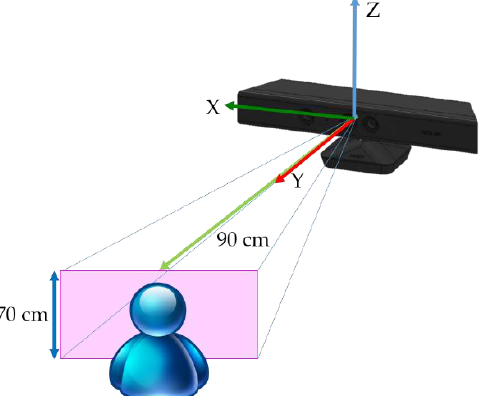
Figure 5. The configuration of data set acquisition using Microsoft Kinect v2.